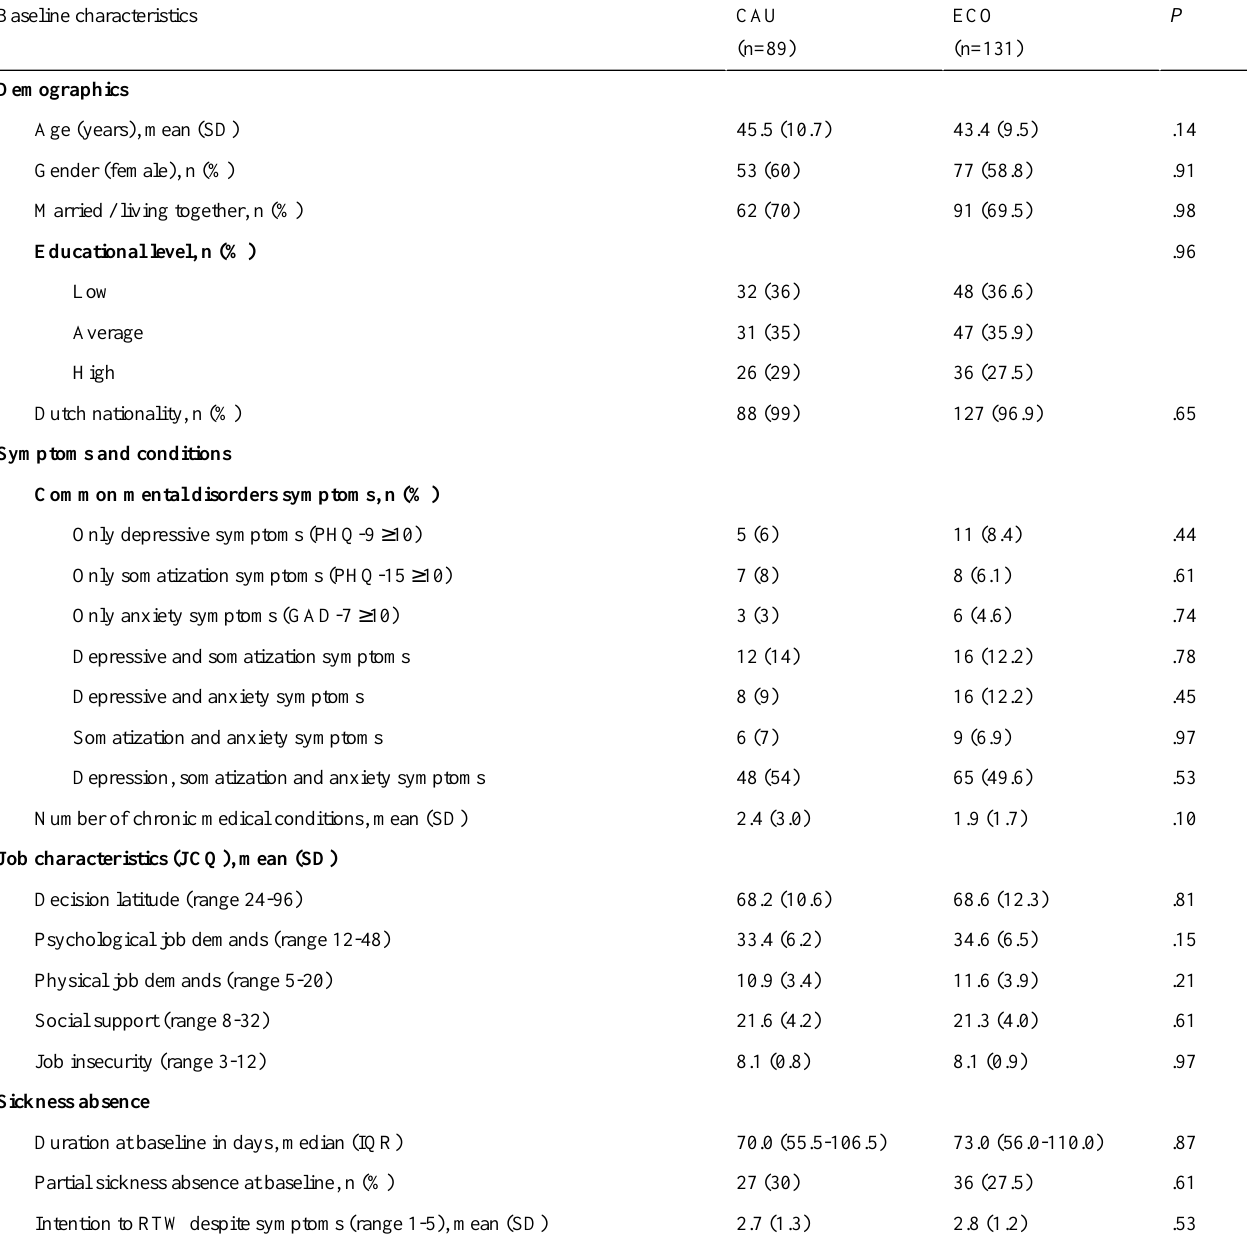
Table 1. Baseline characteristics of the participants in the care as usual (CAU) control and the ECO intervention groups